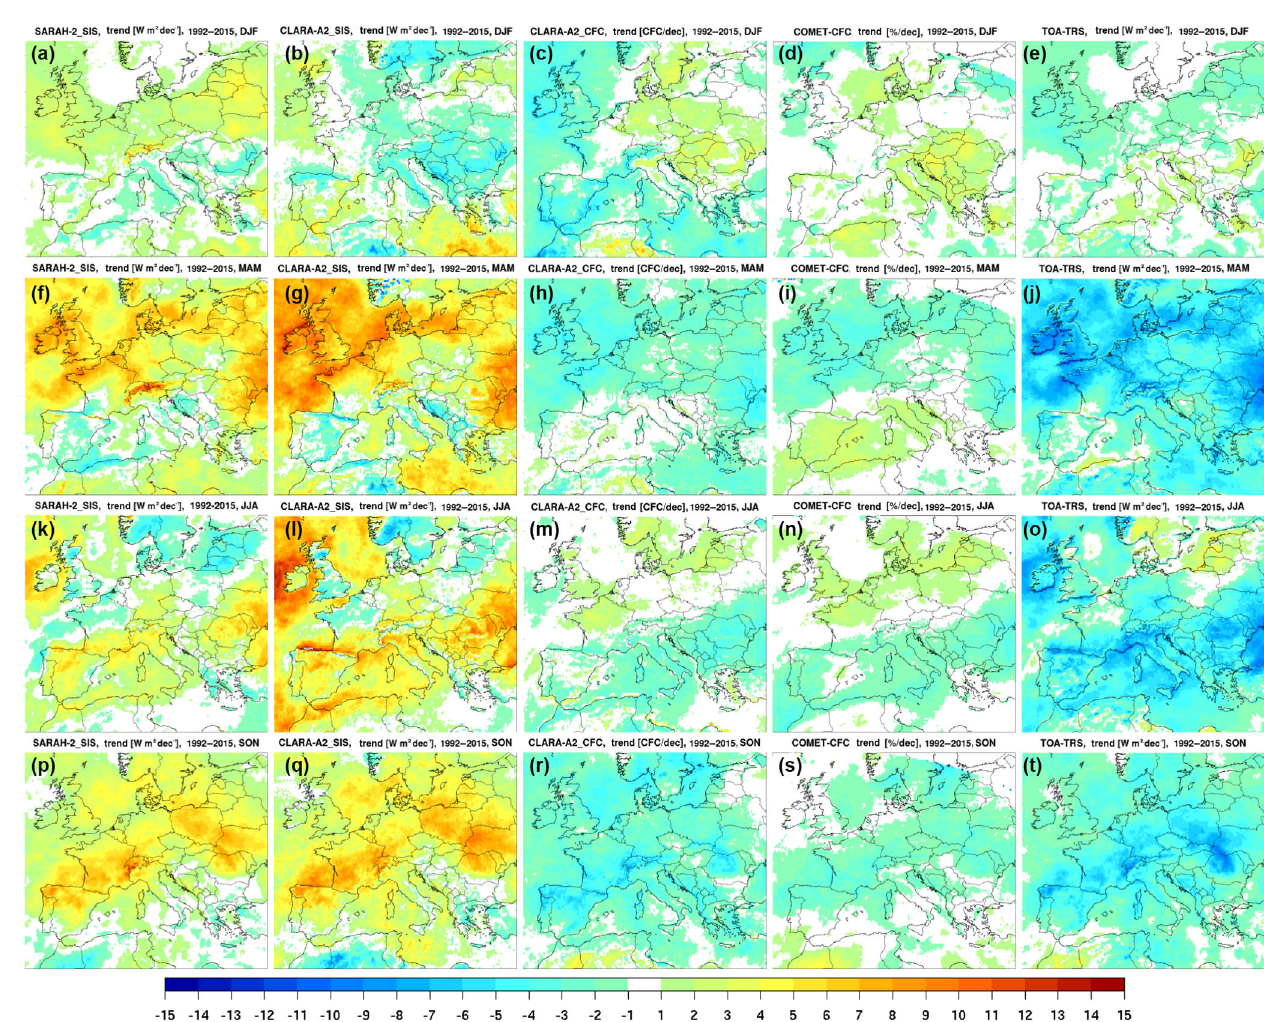
Figure 3. Trends (from left to right) of SARAH-2 SSR [Wm − 2 decade − 1 ], CLARA-A2 SSR [Wm − 2 decade − 1 ], CLARA-A2 CFC [%decade − 1 ], COMET CFC [%decade − 1 ] and TRS [Wm − 2 decade − 1 ] for the different seasons (from top to bottom) winter (DJF), spring (MAM), summer (JJA) and autumn